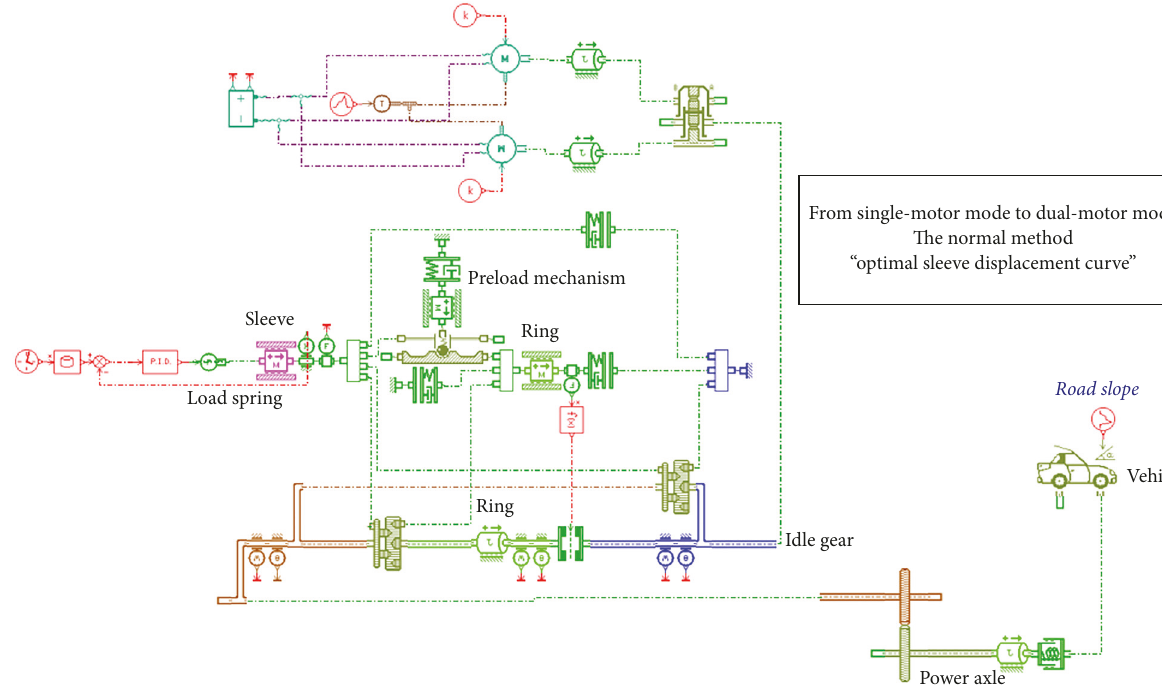
Figure 15: The simulation architecture diagram of the normal method without speed